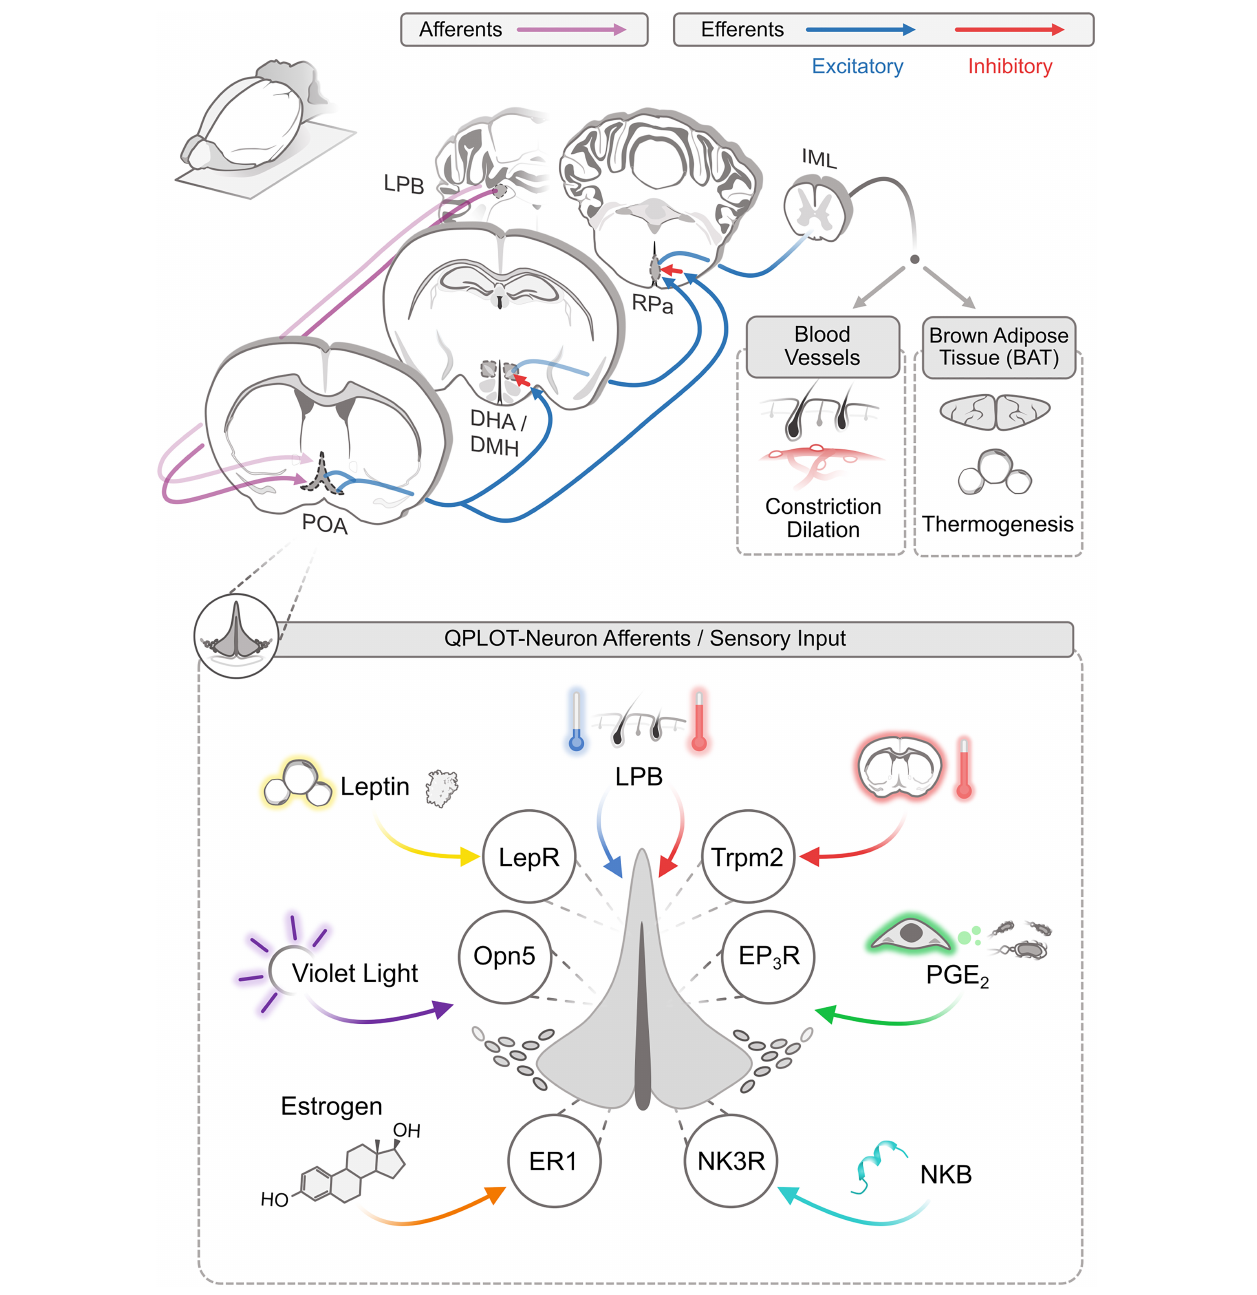
FIGURE 2 | Afferent and efferent thermoregulatory signaling for QPLOT neurons. Schematic of connectivity of QPLOT neurons that mediate body temperature regulation. QPLOT neurons are responsive to numerous stimuli that are integrated to produce the appropriate response.